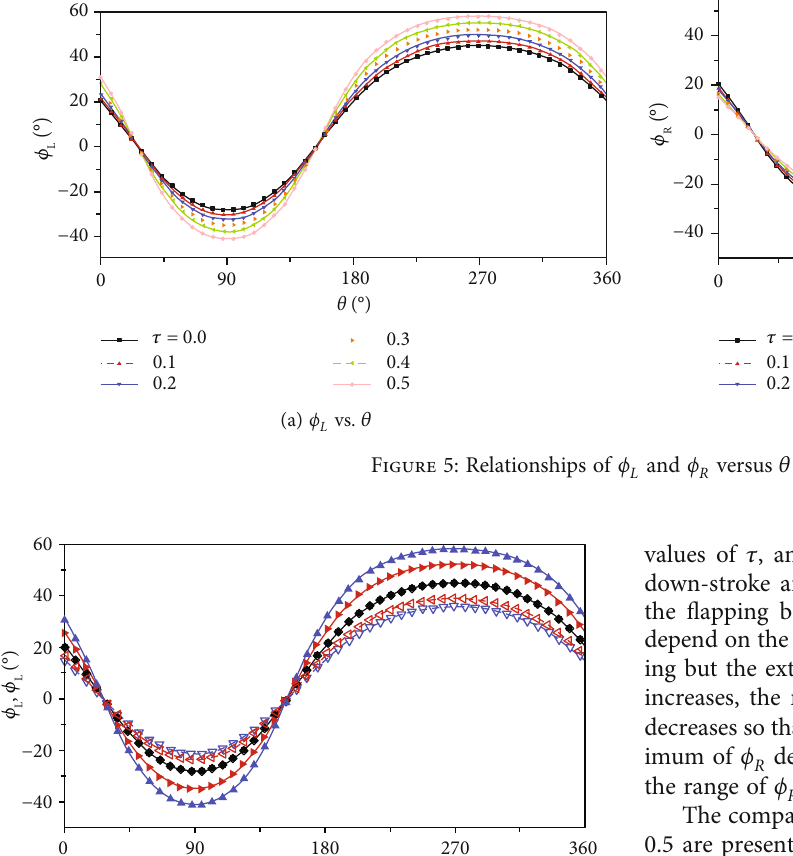
Figure 6: Comparison between ϕ